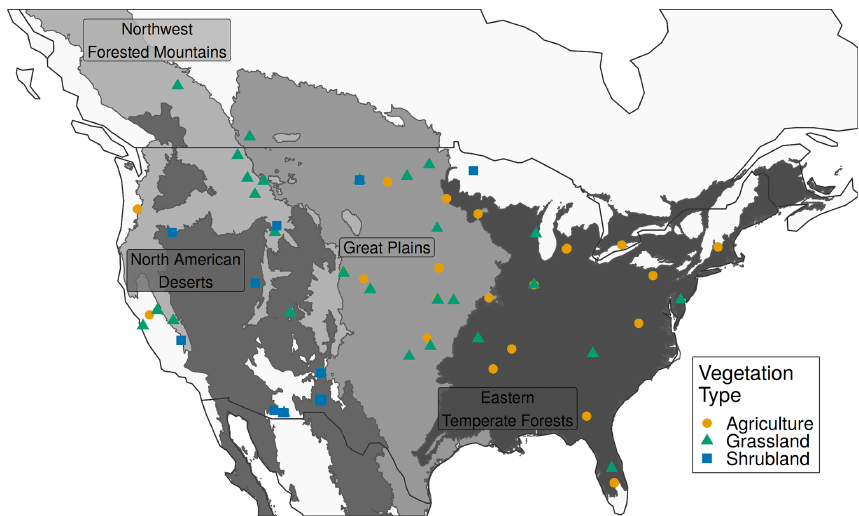
Figure 1. Locations of PhenoCam sites. Color indicates the vegetation type represented at each site. Vegetation type is defined by the